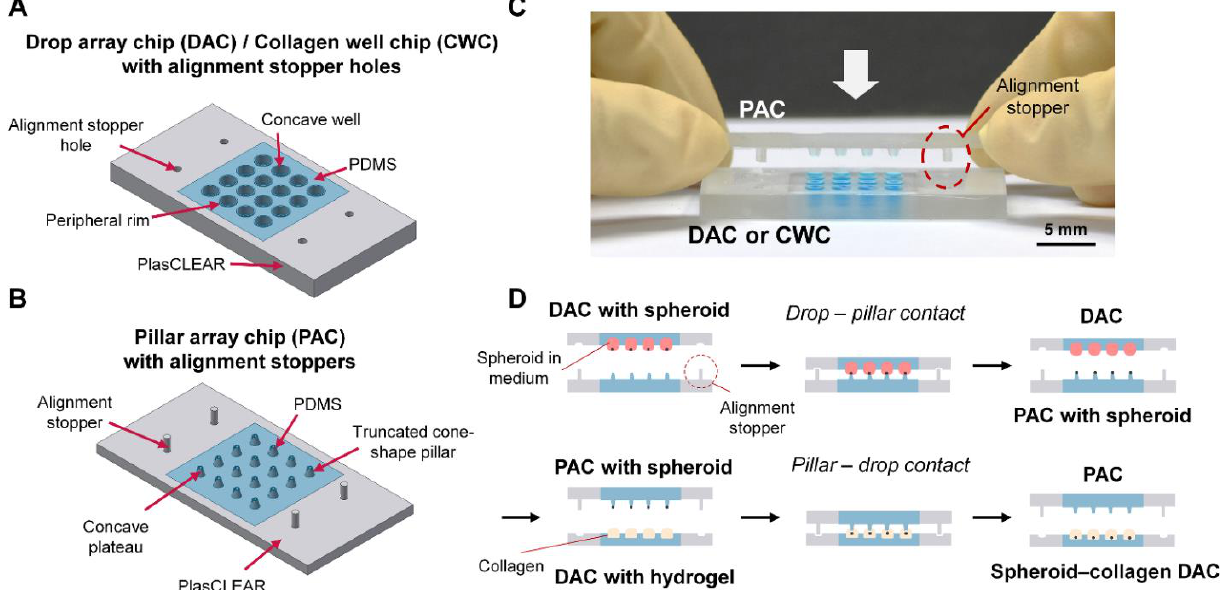
Figure 1. Schematic illustrations of the droplet-contact based spheroid transfer (DCST) devices and the working principle. Design of ( A ) the drop array chip (DAC) or collagen array chip (CWC) with alignment holes and ( B ) the pillar array chip (PAC) with alignment stoppers. ( C ) Image of the improved DCST method in action. ( D ) Working principle of the DAC with alignment stopper holes and the PAC with alignment stoppers using the improved DCST method.